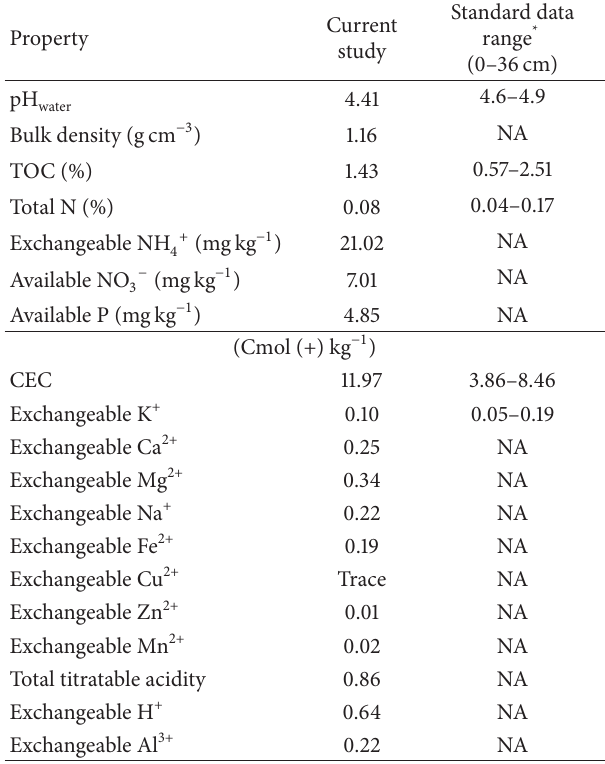
Table 1: Selected chemical properties of Typic Paleudults (Bekenu Series) soil before incubation and pot